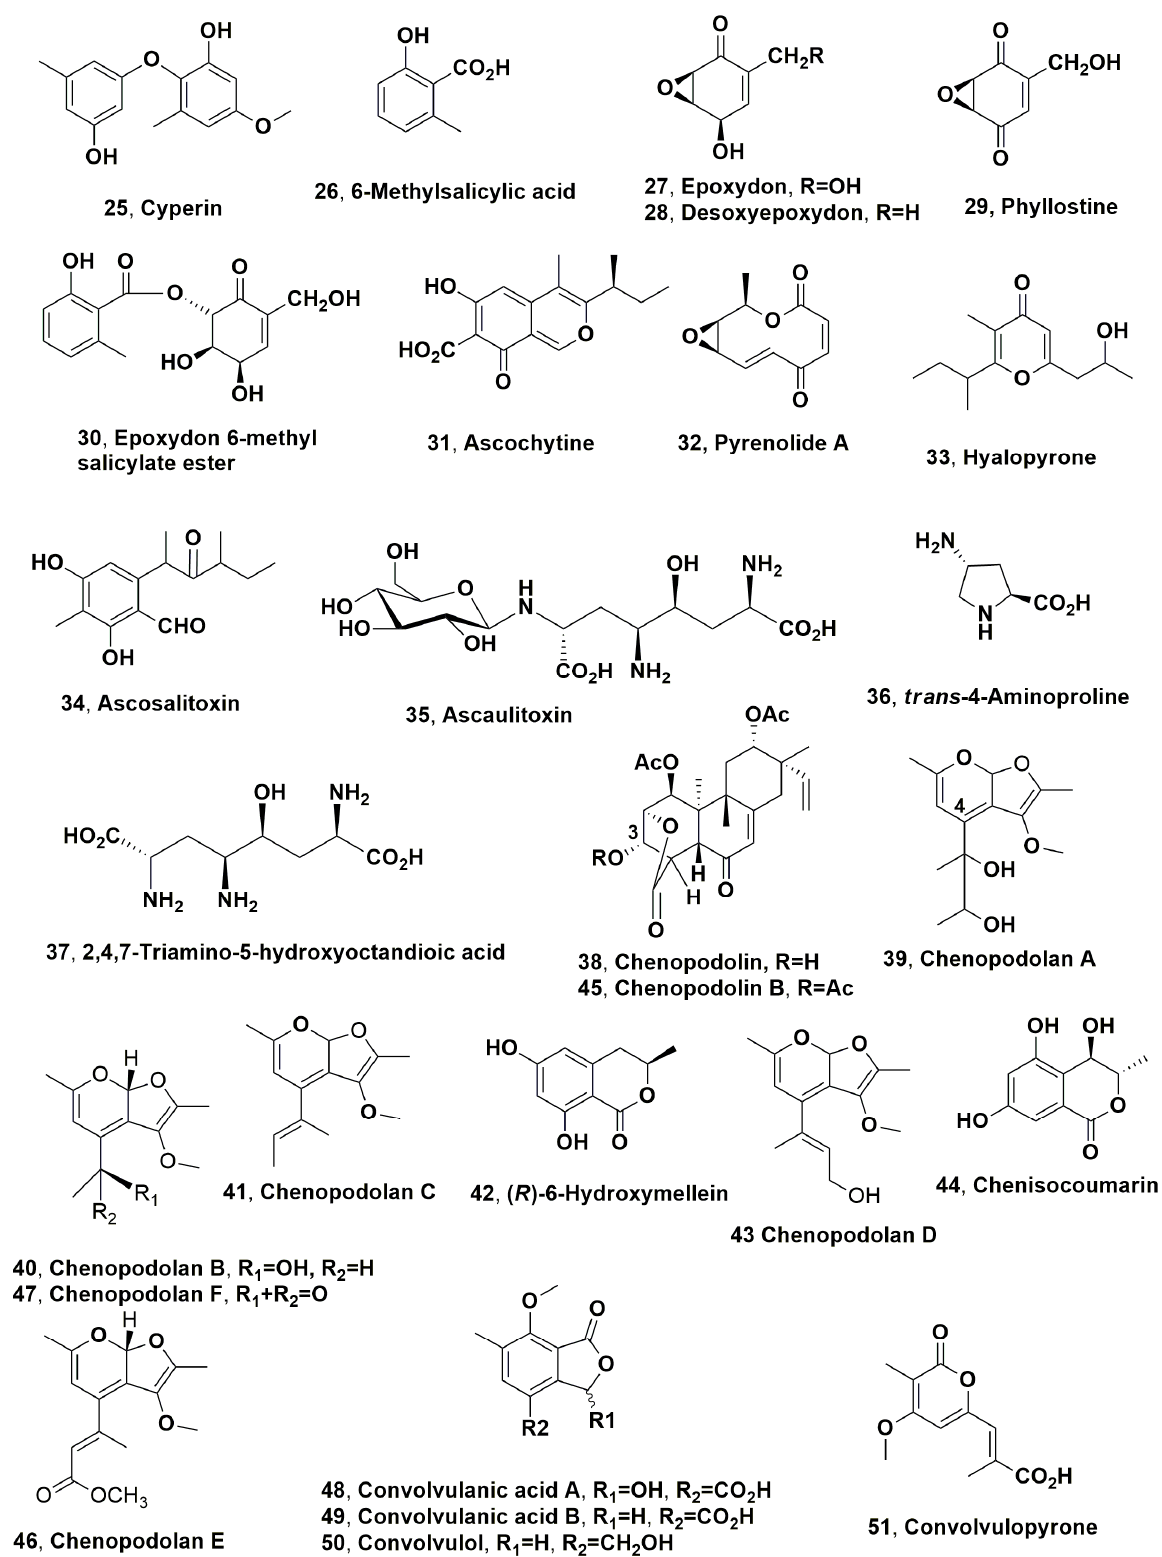
Figure 2. Metabolites produced by Ascochyta cypericola ( 25 ), Phoma sorghina ( 25 – 30 ), Ascochyta hyalospora ( 31 – 33 ), Ascochyta pisi ( 34 ), Ascochyta caulina ( 35 – 37 ), Phoma chenopodiicola ( 38 – 47 ), Phomopsis convolvulus ( 48 – 51 ).